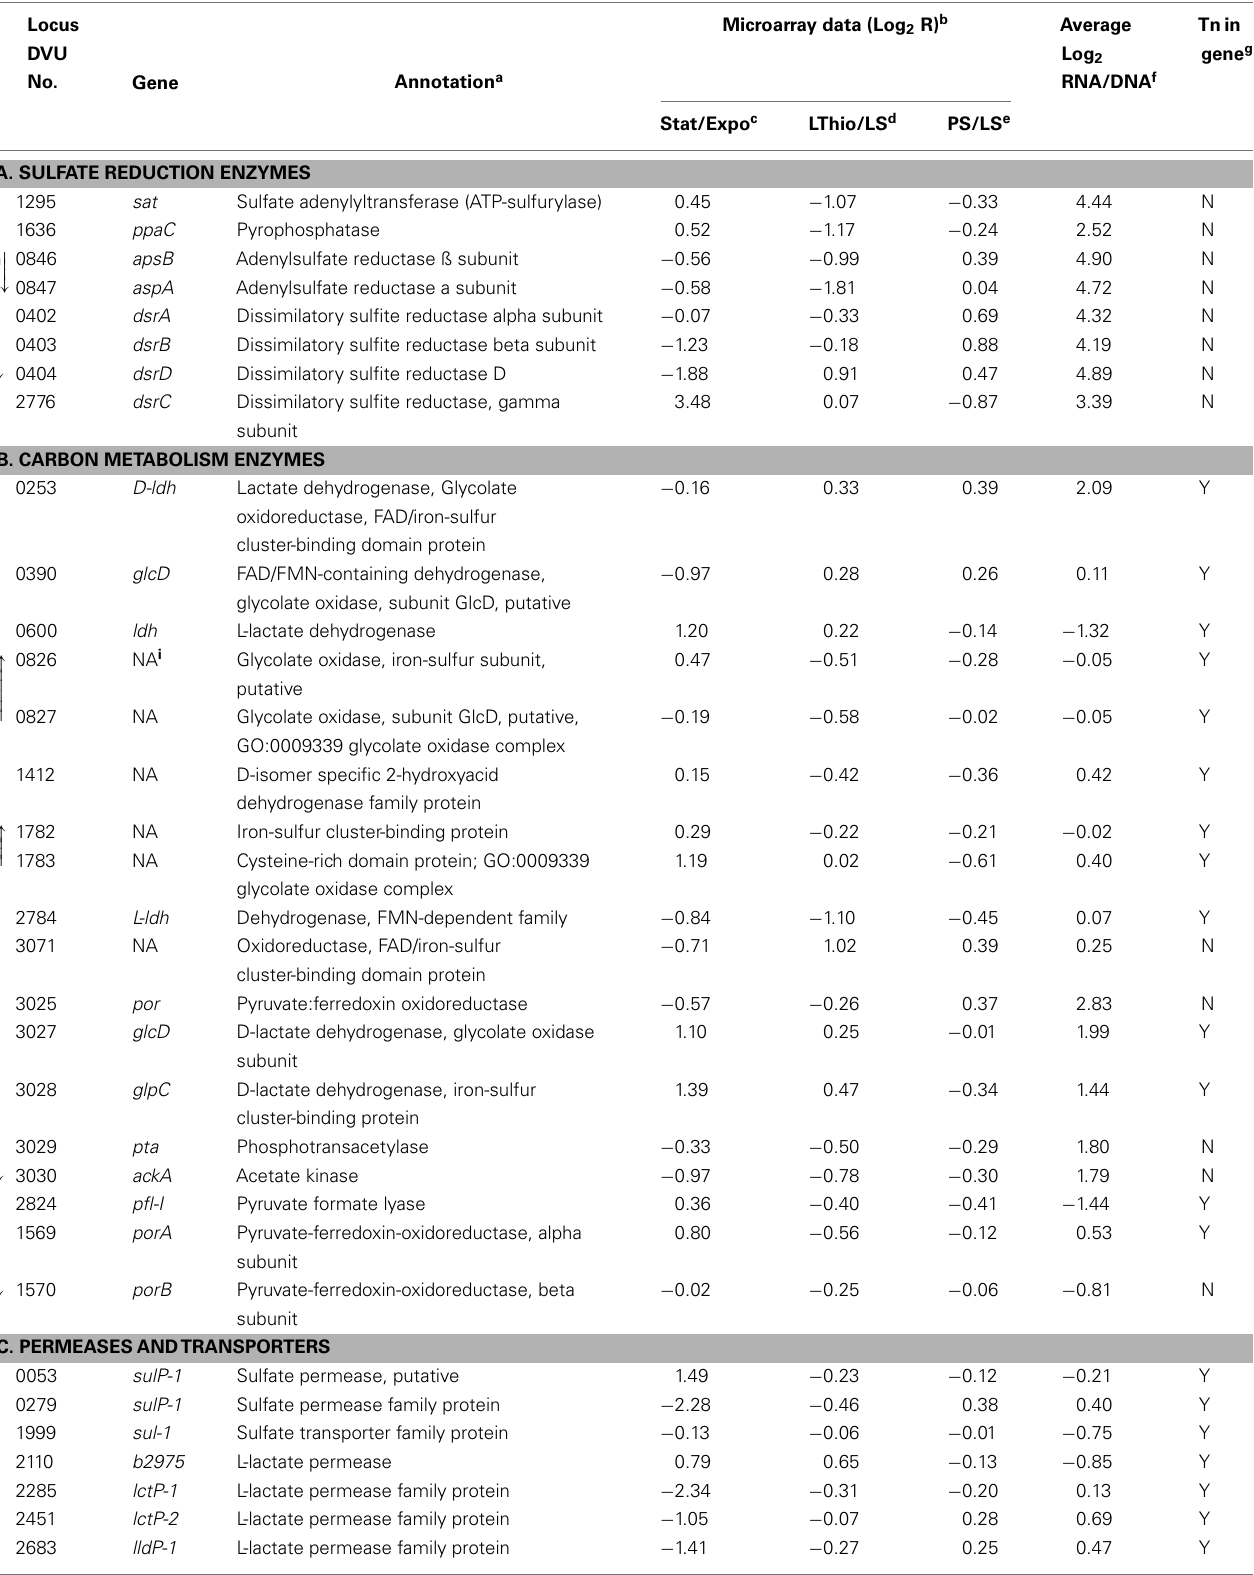
Table 1 | Expression of genes encoding enzymes putatively involved in Lactate/Sulfate growth of Desulfovibrio vulgaris Hildenborough. Locus DVU